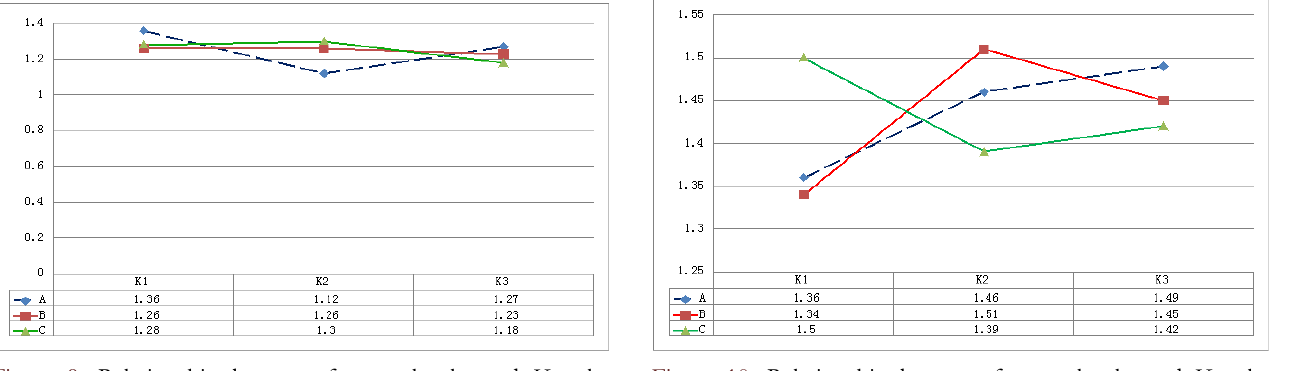
Figure 9: Relationship between factors, levels, and K values (carbon fiber).